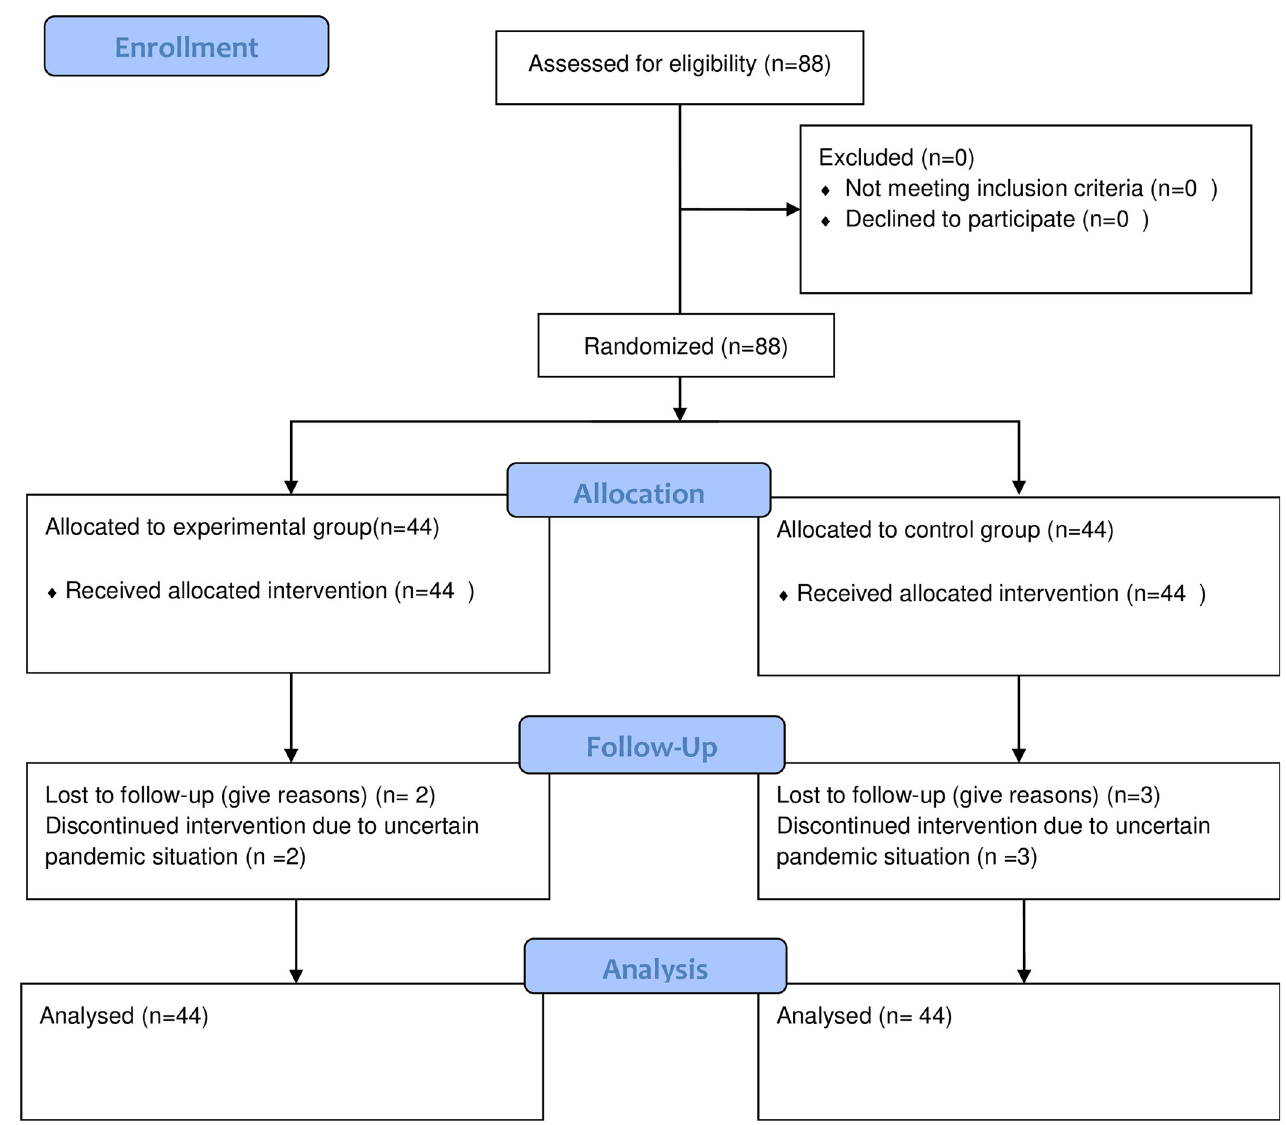
Fig 1. Consort flow